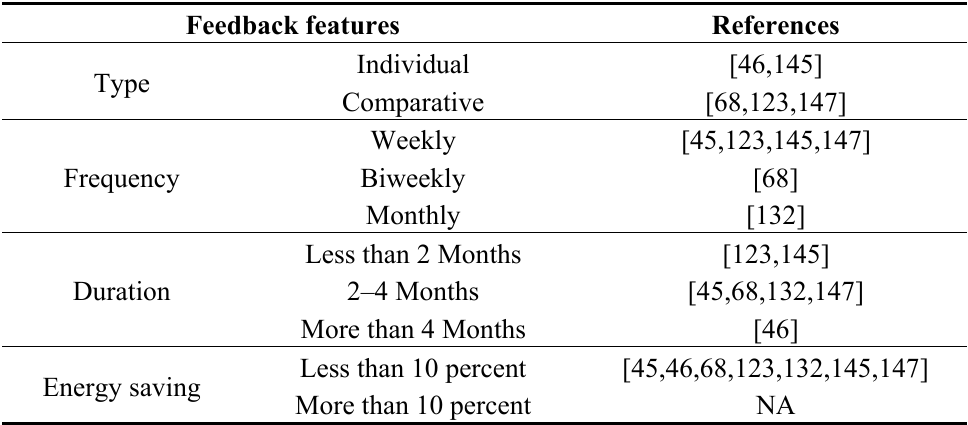
Table 1. Summary of feedback